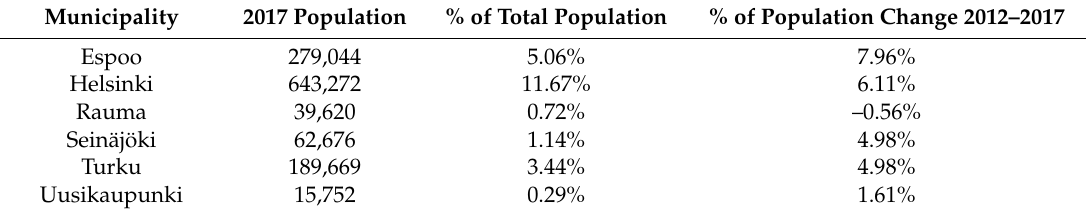
Table 2. Municipalities represented by interview participants.